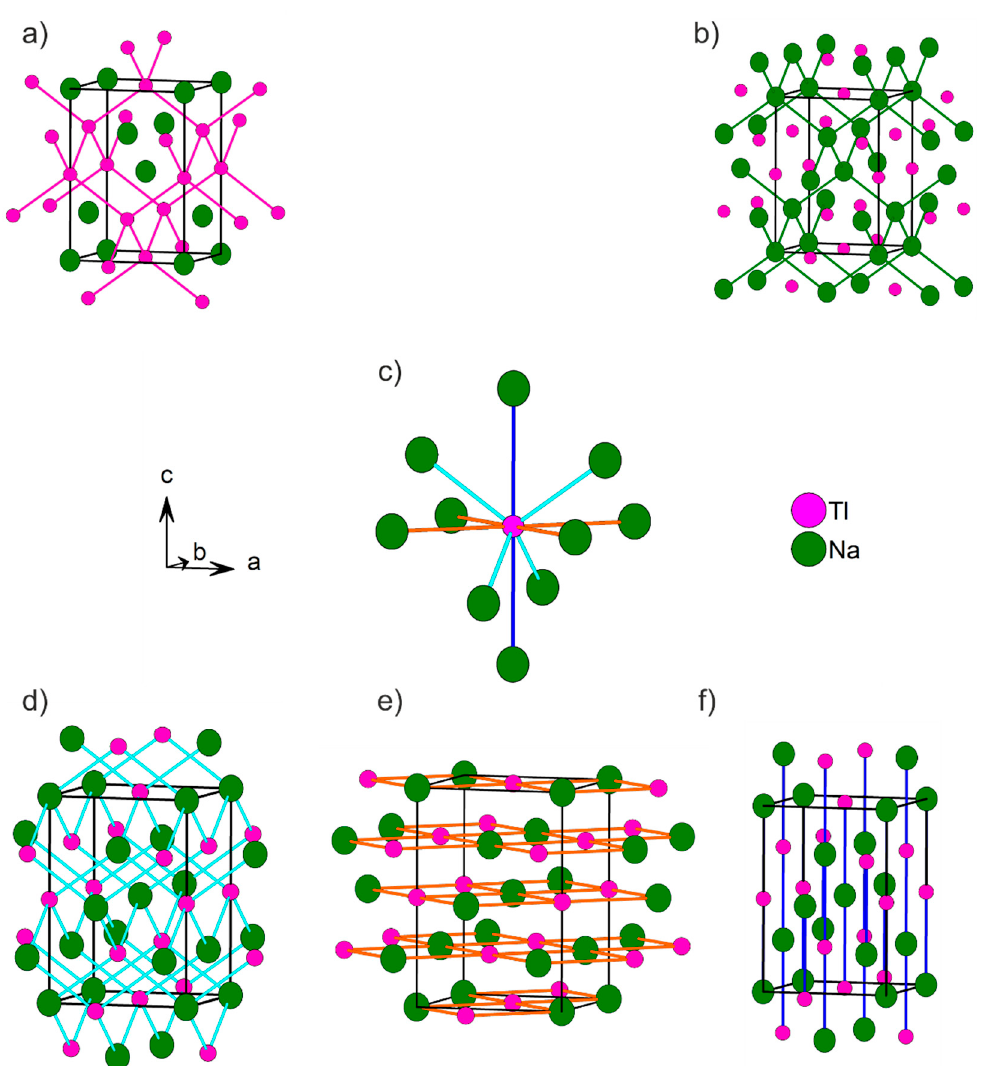
Figure 4. Distances in NaTl: ( a ) Diamond sublattice of thallium in NaTl; ( b ) sodium sublattice in NaTl; ( c ) coordination of thallium in NaTl with the different Tl–Na distances depicted in different colors (d(Tl–Na) dark blue = 3.7645(3) Å, d(Tl–Na) light blue = 3.22363(17) Å, d(Tl–Na) orange = 3.70105(19) Å); ( d ) the short Tl–Na distance results in a tetrahedral network with thallium and sodium being involved in the unit cell; ( e ) compressed Tl–Na distance is situated in the a/b plane of the unit cell; and ( f ) the elongated Tl–Na distance is located parallel to the c-axis in the unit cell.